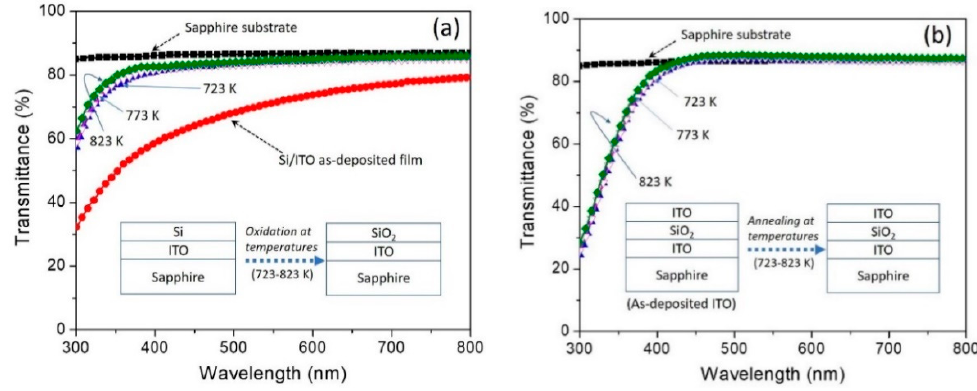
Figure 6. Optical transmittance spectra: ( a ) as-deposited and oxidized Si/ITO/sapphire, ( b ) ITO/SiO 2 /ITO/sapphire films which are annealed for 1 h after the ITO top layer deposition on SiO 2 /ITO/sapphire.